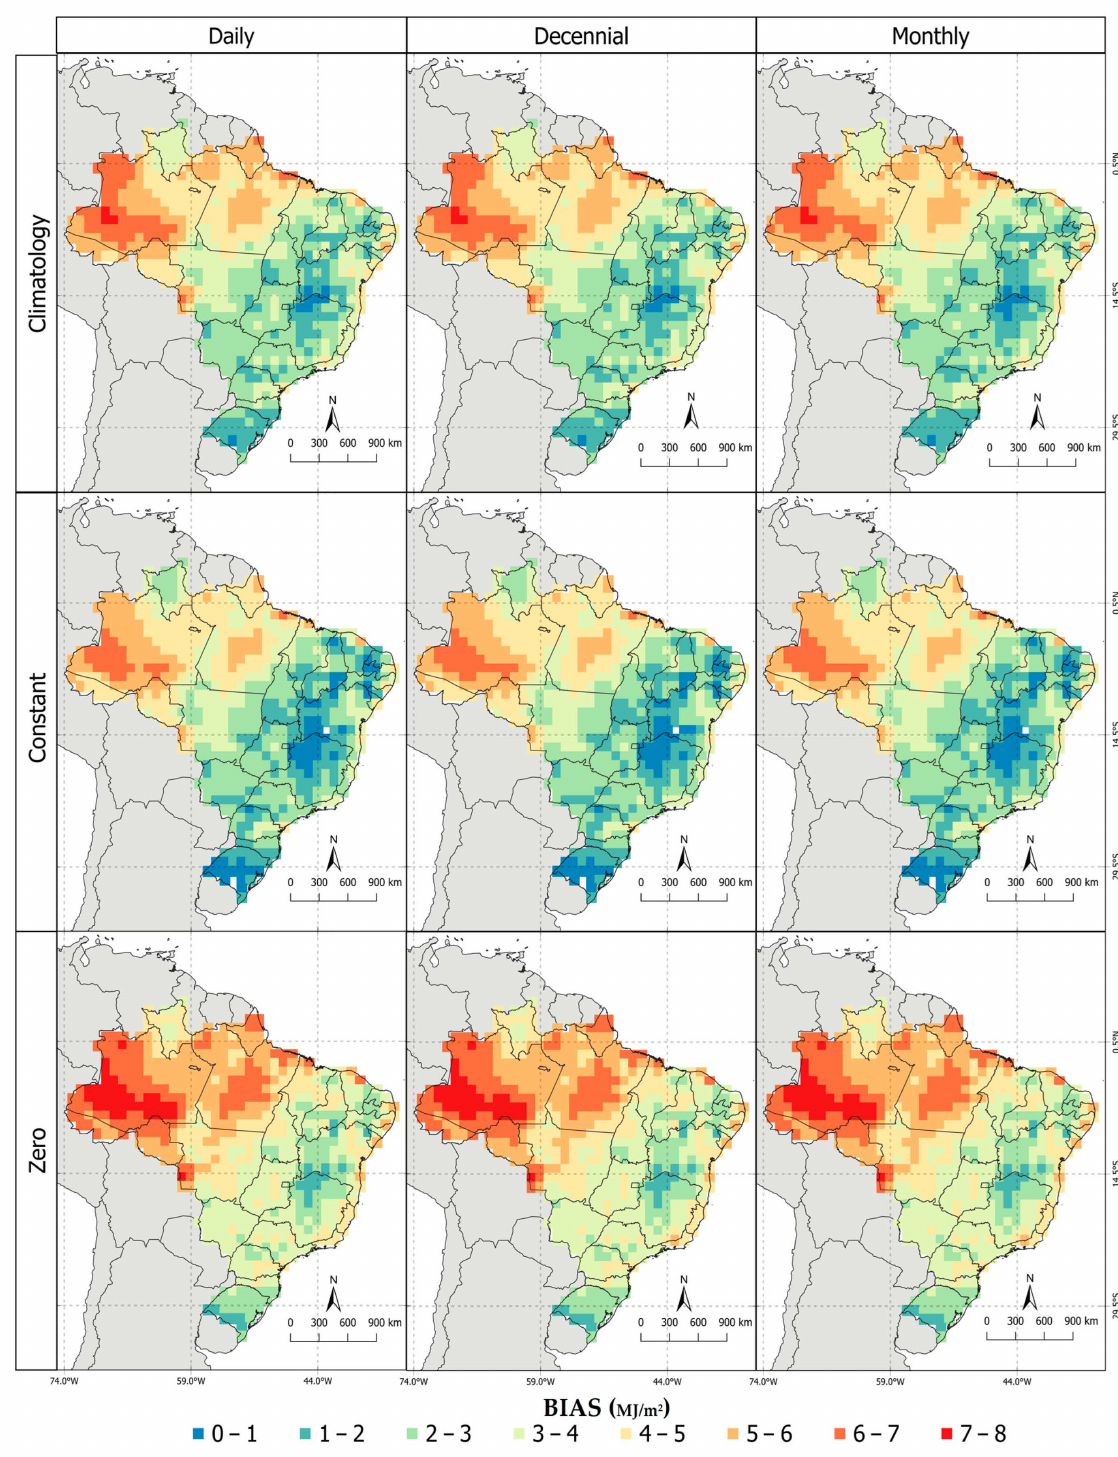
Figure 5. Solar radiation BIAS (MJ/m 2 ). The upper panel is derived from the BAM-CLIM simulations, the middle panel is derived from the BAM-CTE simulations, and the bottom panel is derived from the BAM-ZERO simulations. The left column shows BIAS on a daily scale, the middle column shows BIAS on a decennial scale, and the right column shows BIAS on a monthly